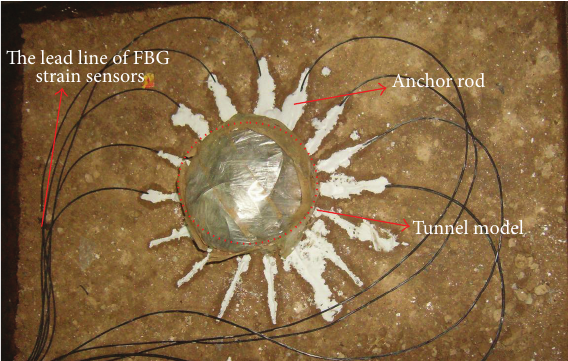
Figure 3: Anchor rods installed in